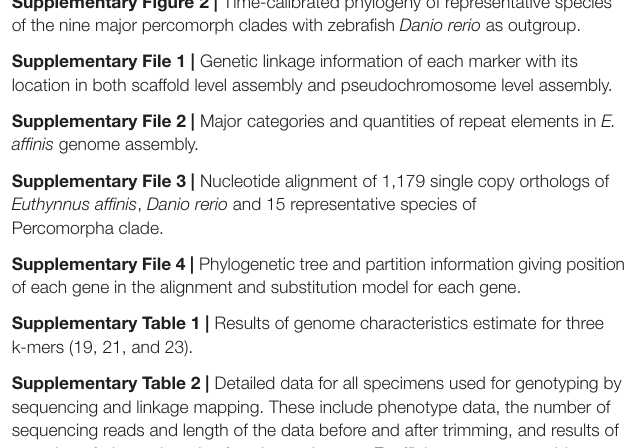
Supplementary Figure 1 | Length distribution of kawakawa Euthynnus affinis genome assembly. Supplementary Figure 2 | Time-calibrated phylogeny of representative species of the nine major percomorph clades with zebrafish Danio rerio as outgroup. Supplementary File 1 | Genetic linkage information of each marker with its location in both scaffold level assembly and pseudochromosome level assembly. Supplementary File 2 | Major categories and quantities of repeat elements in E. affinis genome